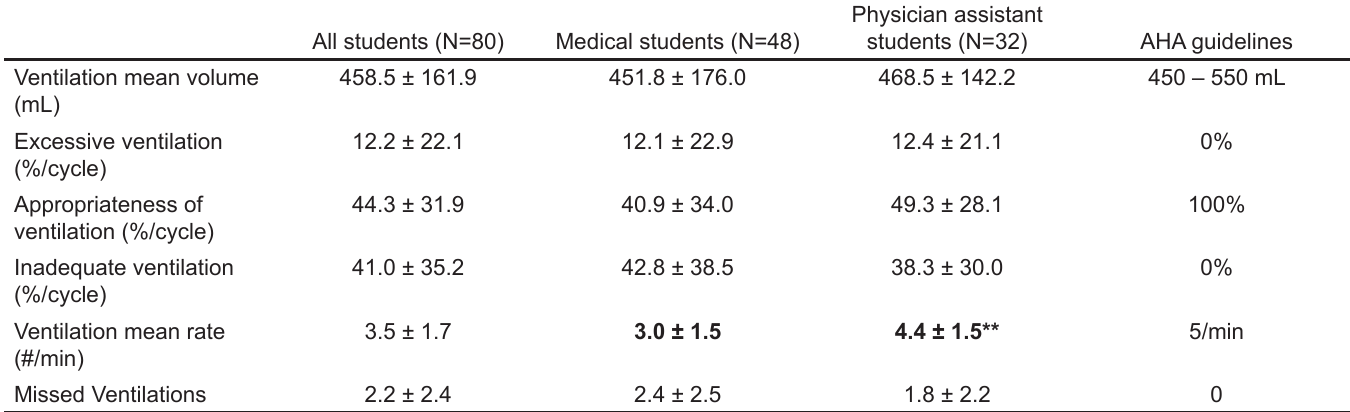
Table 3. Ventilation data across student type.